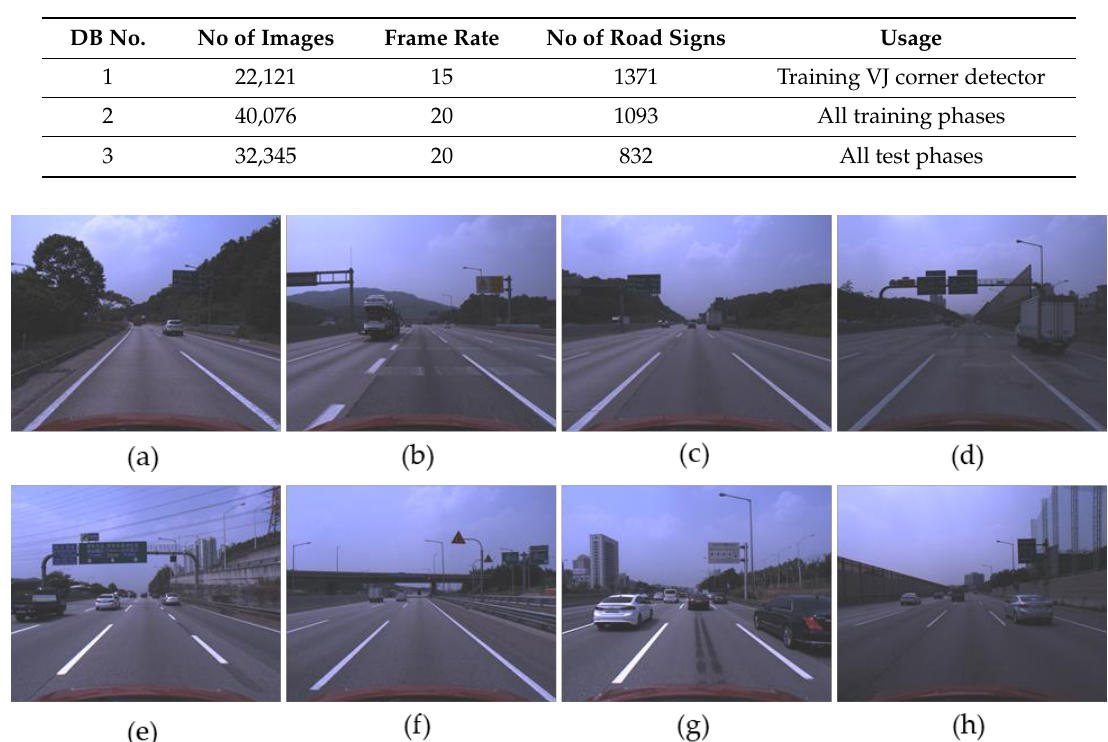
Figure 11. Examples of the experimental database. ( a ) low contrast between a road sign and background, ( b ) a road sign consisting of two colors, ( c ) low contrast between a road sign and background, ( d ) general road signs, ( e ) a road sign having large aspect ratio, ( f ) a road sign which is far from a camera, ( g ) a white road sign, ( h ) a road sign having small aspect ratio.